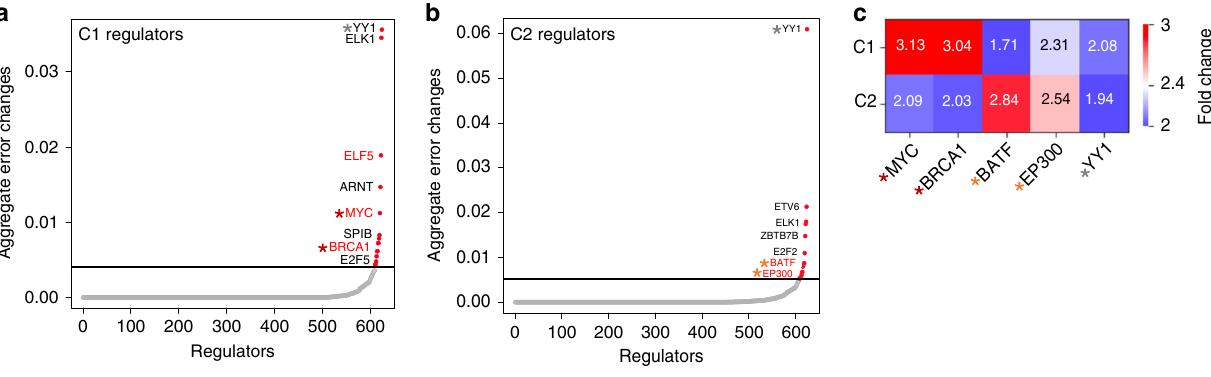
Fig. 4 Sub-compartment-speci fi c transcription factor prediction. a – b Scatter plot showing sub-compartment-speci fi c transcription factors (TFs) participating in transcriptional regulation predicted by elastic net regression for C1 and C2 sub-compartment. The star indicates TFs with the ChIP-seq data available from ENCODE (red: C1-speci fi c regulators, orange: C2-speci fi c regulator, and gray: shared regulator). c Heatmap of ChIP-seq enrichment for MYC, BRCA1, BATF, EP300, and YY1 TFs across